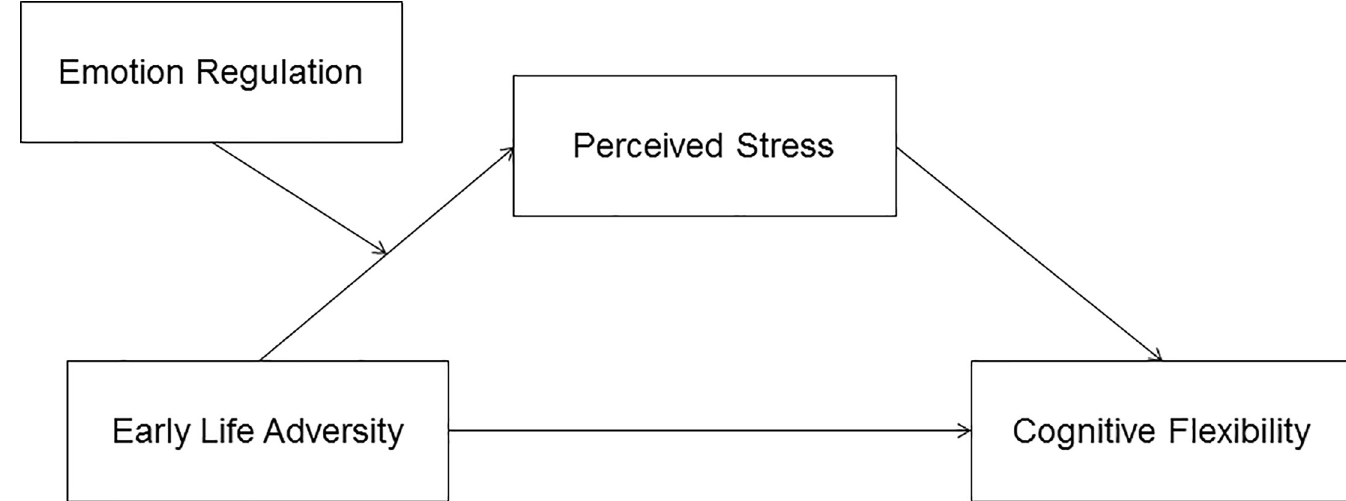
Fig 1. Moderated mediation model being tested using Hayes’ PROCESS model 7.